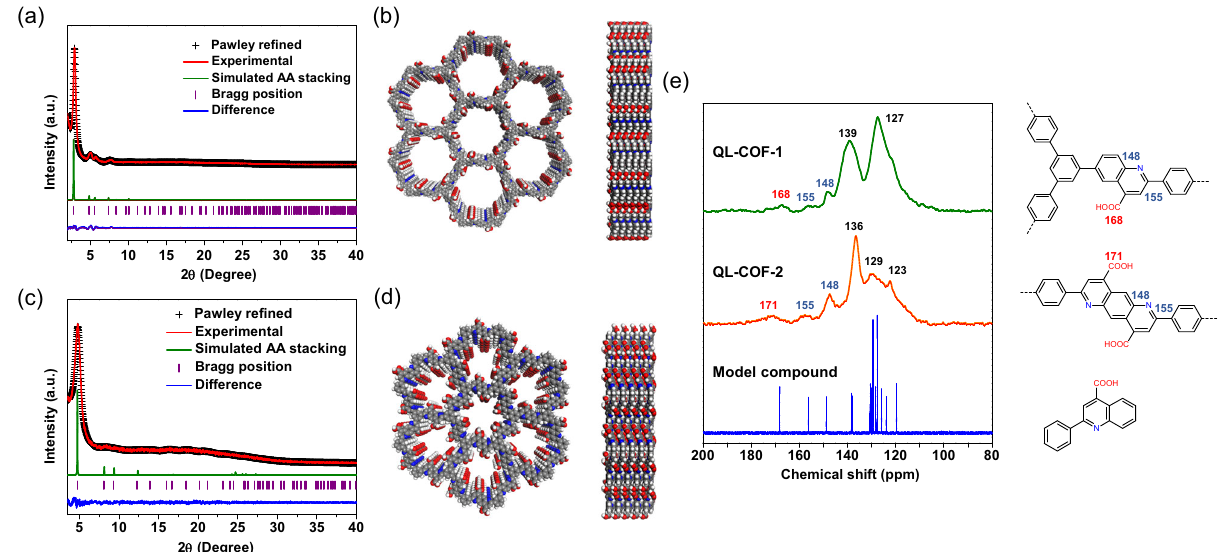
Fig. 2 Crystal and chemical structure of QL-COF-1&2. a , c PXRD patterns of QL-COF-1 and QL-COF-2. Comparison of the experimental PXRD patterns (red) with the Pawley re fi ned pattern (black), simulated pattern for AA stacking (green) and difference plot (blue). b , d Views of AA stacking model for QL- COF-1 and QL-COF-2. e The 13 C NMR spectra of QL-COF-1 (green), QL-COF-2 (orange) and model compound (blue). All above date were measured on powder